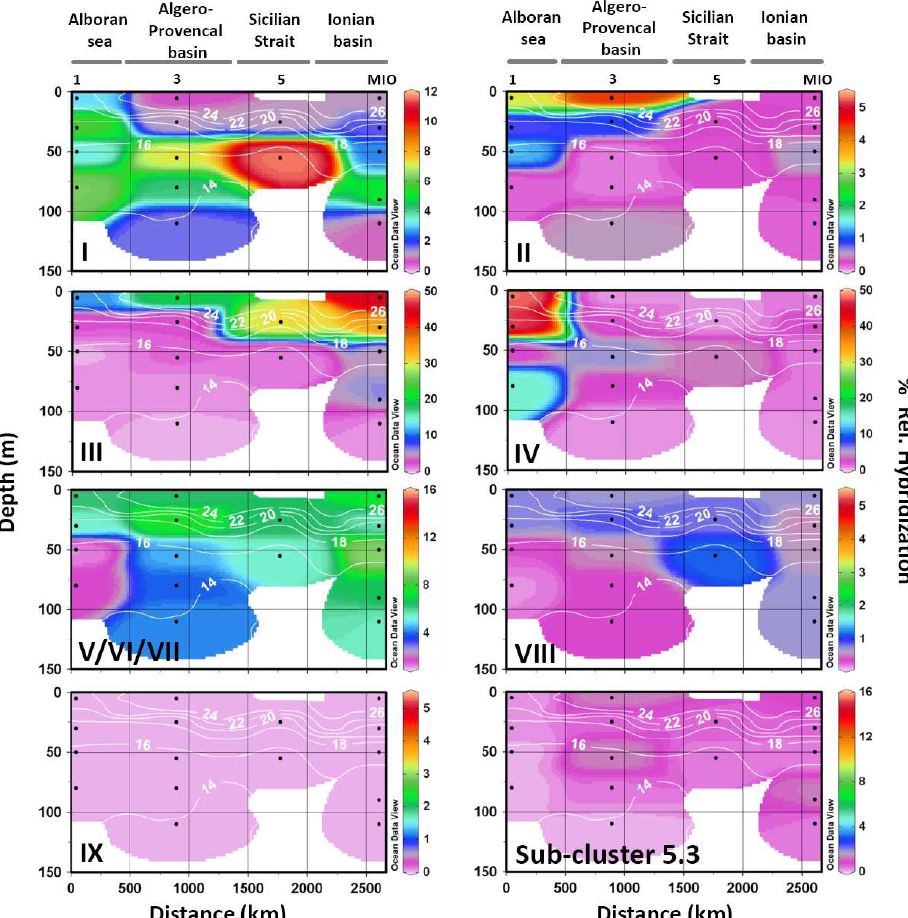
Fig. 6. Vertical distribution of different phylogenetic groups of Synechococcus along the W-E part of PROSOPE cruise track, as analyzed by dot blot hybridization using 16S rRNA gene specific oligonucleotide probes targeting sub-cluster 5.1 clades I to IX and sub-cluster 5.3. See Table 1 for correspondence to sequenced strains. For each panel, the x axis represents the cumulative distance in kilometers from a site W of Sta. 1 (36.2 ◦ N–5.8 ◦ W) and the y axis represents depth in meters. Details of panels are as described in Fig. 2. Note the different ranges of % relative hybridization values between